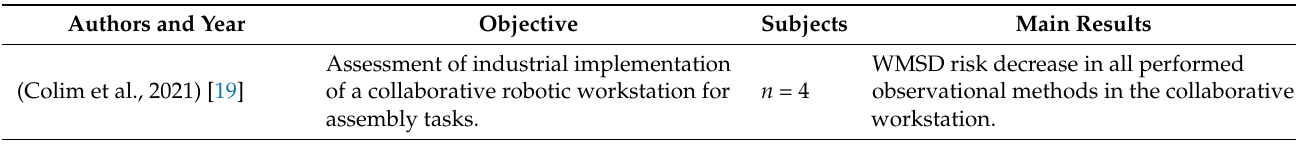
Table 1. Summary of the reviewed studies related to physical ergonomics (presented in chronological order of publication). * denotes studies with online